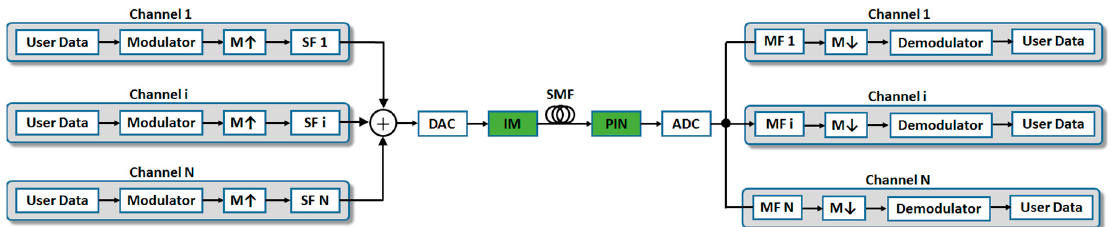
Figure 1. Digital orthogonal filtering-based channel multiplexing: SF, shaping filter; DAC, digital to analogue converter; IM, intensity modulator; ADC, analogue to digital converter; MF, matching filter; M ↑ , up-sampling by factor M; M ↓ , down-sampling by factor M.